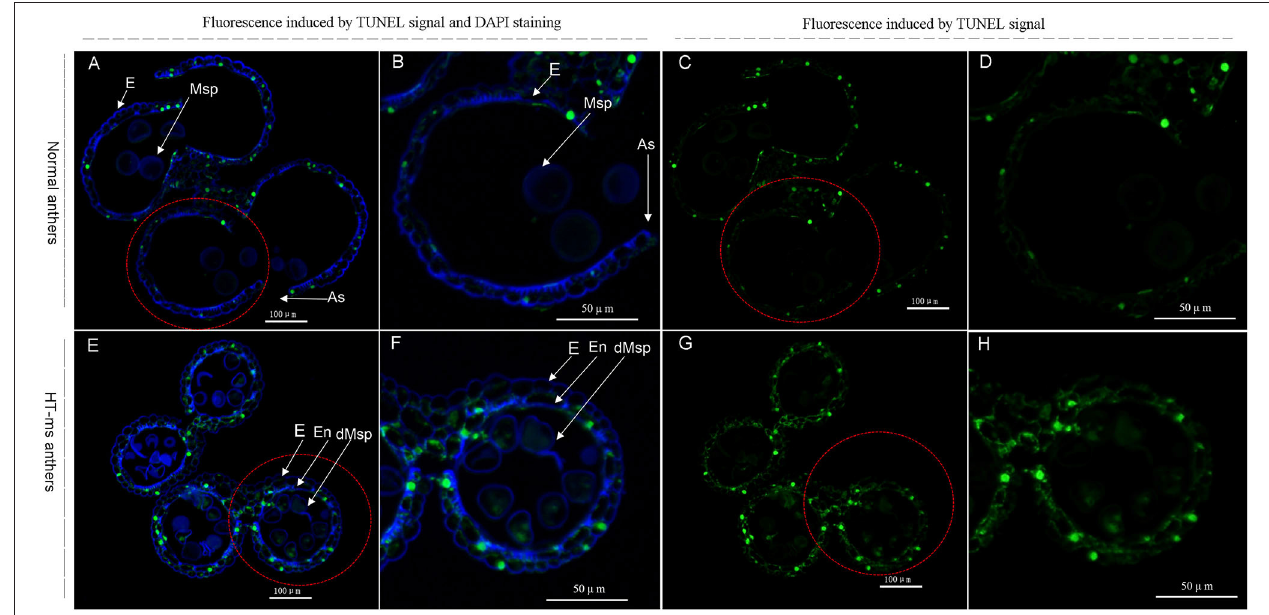
FIGURE 8 | TUNEL assays to detect anther tapetum programmed cell death (PCD) in Normal anthers and HT-ms anthers at the trinucleate stage. As, anther slit; E, epidermis; En, endothecium; Msp: microspores. dMSP: degenerated microspore. The yellow-green fluorescence indicates nuclei with TUNEL-positive staining. The marked red dashed circle is the part that needs to be enlarged. (A–D) Normal anthers. (E–H) HT-ms anthers. Scale bars = 100 µ m (A,C,E,G) ; 50 µ m (B,D,F,H) .